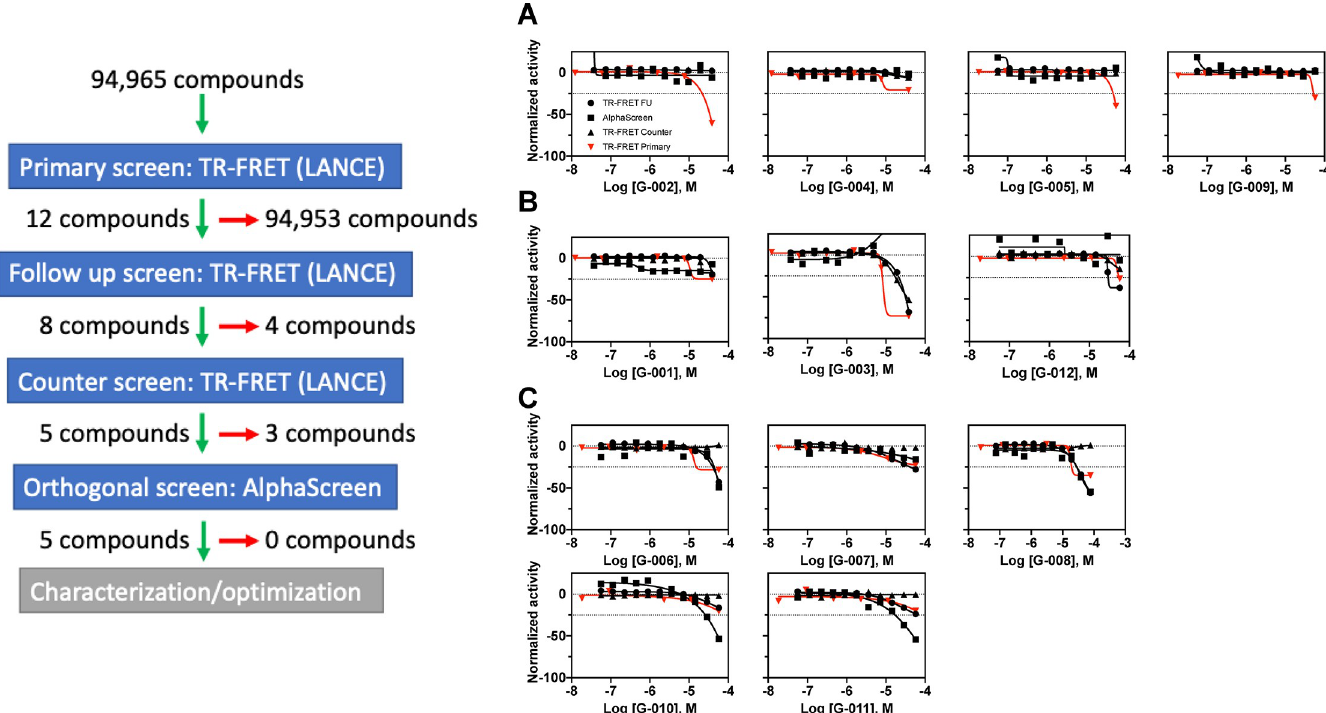
Fig 15. Large library screening workflow and results. Left panel: schematic of screening process showing input library size, assay utilization, advanced compounds (green arrow), and non-advanced compounds (red arrow). Right panel: activity profiles for compounds selected for follow-up testing from the primary screen. Activities are shown for each assay performed and the compound profiles are segregated by level of assay advancement. (A) No activity on TR-FRET follow up. (B) Unacceptable counter screen activity. (C) Confirmed active with AlphaScreen.